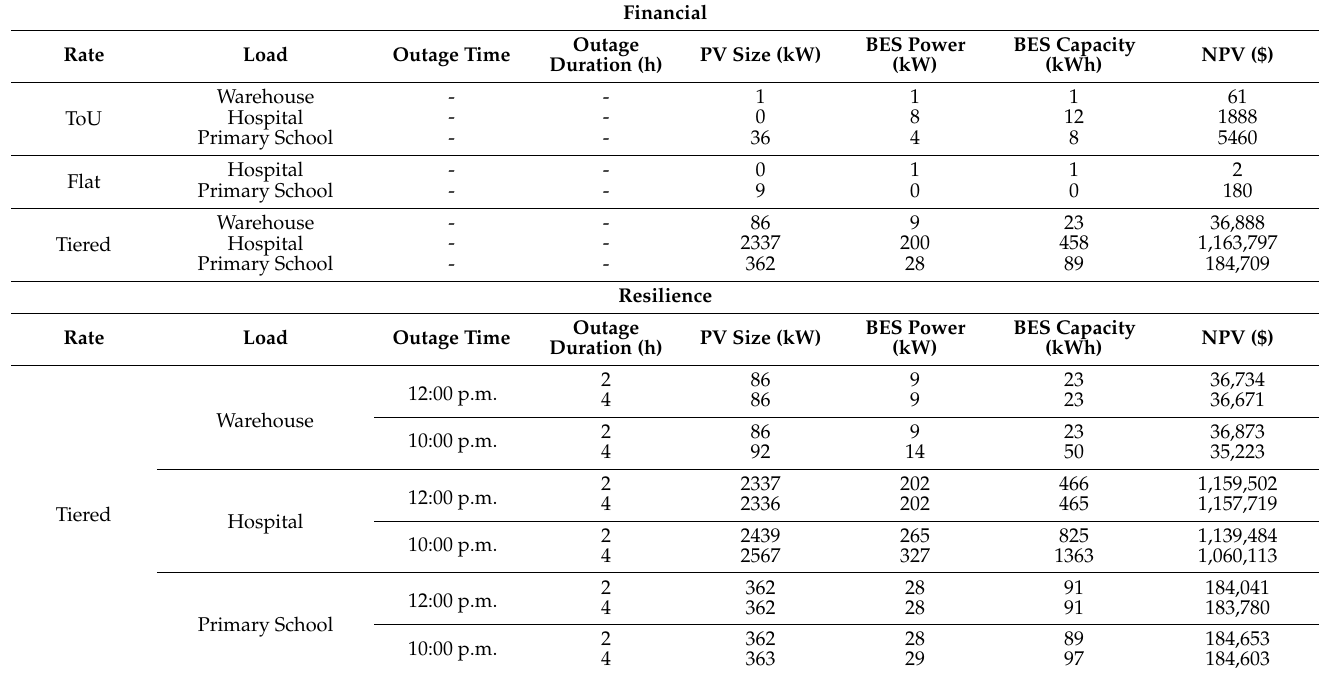
Table 4. Positive NPV results for the commercial loads in the Boston, MA